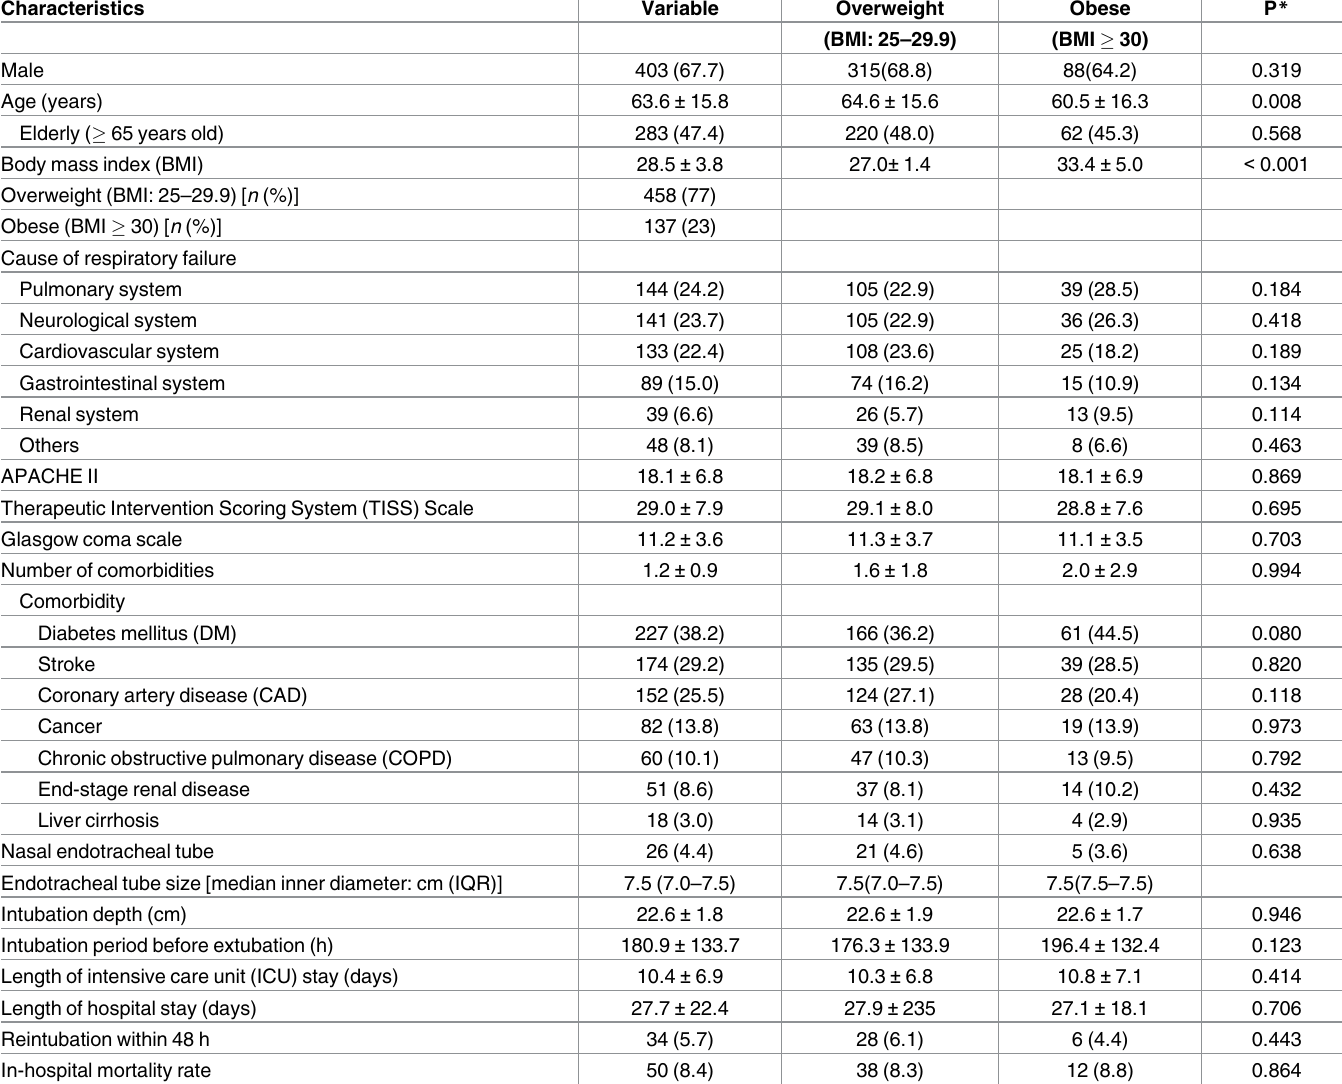
Table 1. Characteristics of overweight (BMI: 25–29.9)and obese (BMI (cid:21) 30) patients treated with mechanical ventilation (MV) for > 48 h and under- going planned extubation ( n = 595).